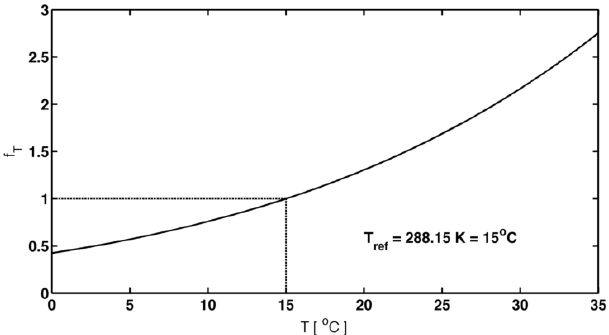
Table A11. Processes modulated by the limiter function f N:Cmax